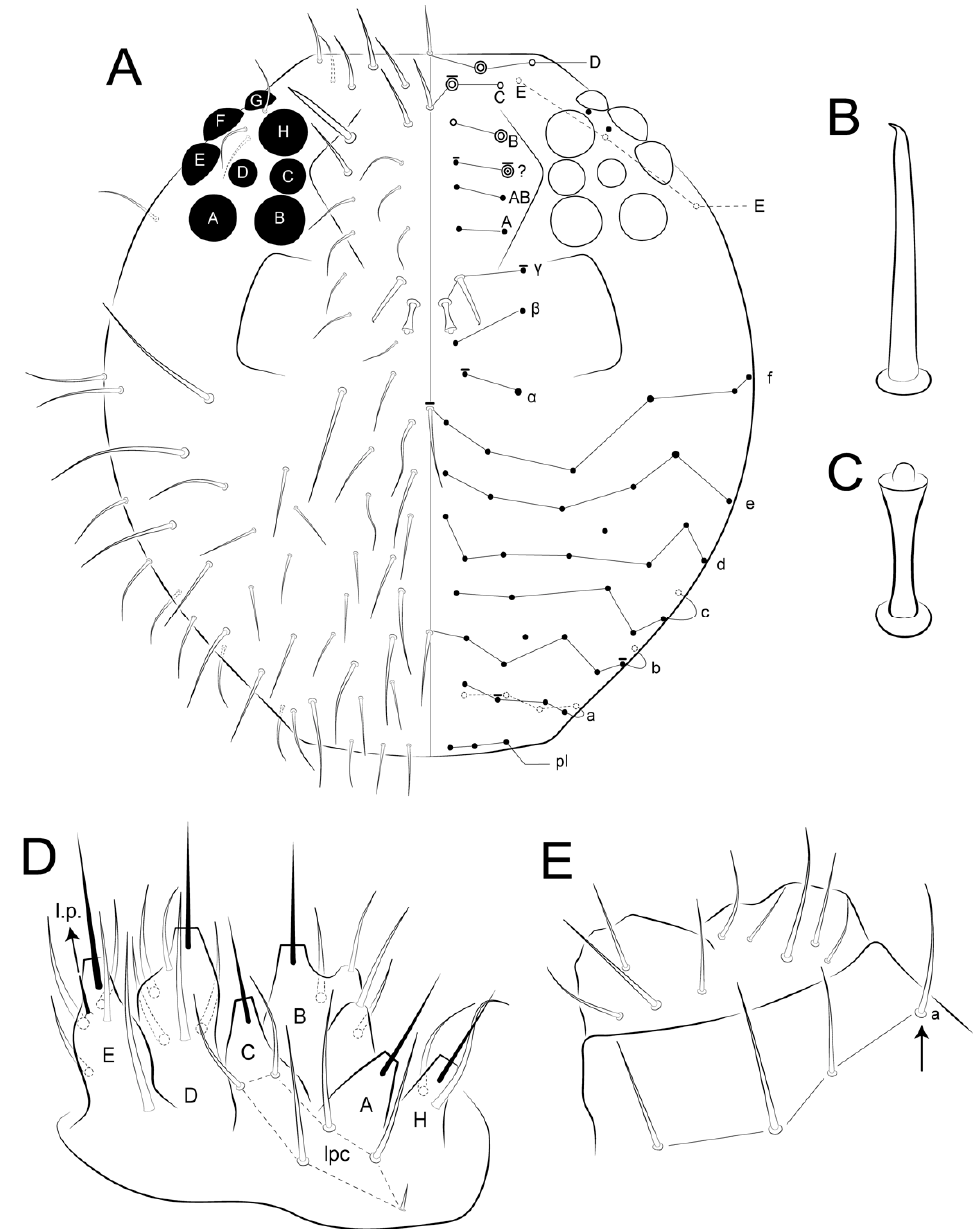
Figure 8. Arlesminthurus caatinguensis sp. nov., male: ( A ) complete head dorsal chaetotaxy (prelabral, clypeal, frontal, interocular and occipital regions); the left side shows the chaetae as observed and the right side a schematic representation; ( B , C ) frontal chaetae modified on the γ line; ( B ) superior chaeta, ( C ) inferior chaeta; ( D ) labial papillae (A–E, and H), and lpc (left side); ( E ) basomedian and basolateral labial fields and postlabial chaetotaxy (right side); arrow indicates ventral chaetae of the a line.